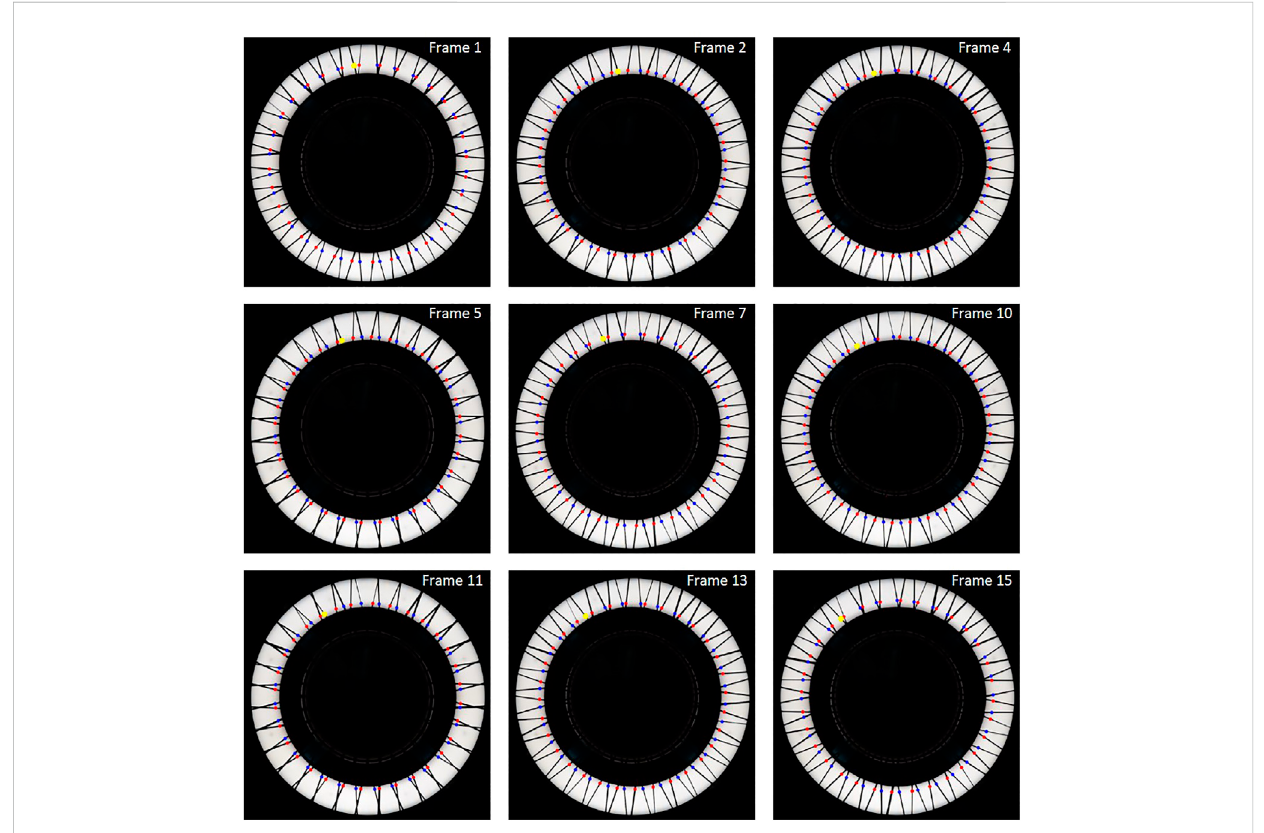
FIGURE 8 Video frames corresponding to the yarn distance diagrams from Figure 6; clockwise yarns marked by red dots; counterclockwise yarns marked by blue dots; defective yarn as identi fi ed from the characteristic pattern in Figure 7 marked by a yellow dot.